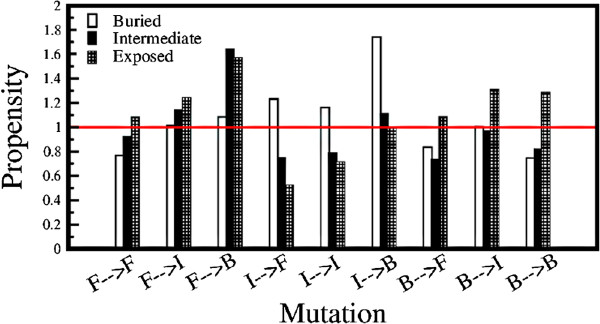
Propensity of resultant residue with different solvent accessibility. Propensity of 9 different types of mutations resulting in different solvent accessible (buried, intermediate and exposed) residues generating a helical conformation from the non-redundant database which map into non-helical conformation in the SCOP database. The propensity depicted here is similar to that shown in Figure 3. However, while calculating this propensity solvent accessibility of the resultant mutant residue is considered rather than solvent accessibility of the mutated residue.